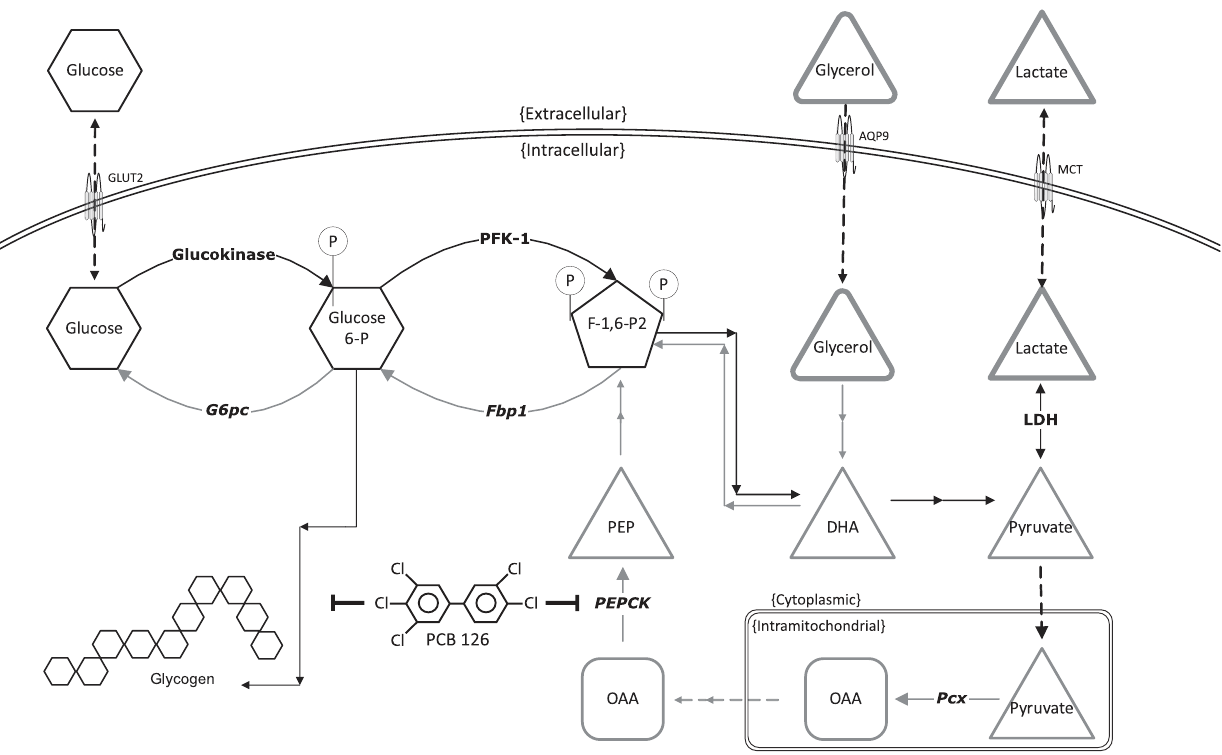
Figure 7. Simplified visual model of the impact of PCB 126 on hepatic glucose metabolism. Glycolysis, glycogen synthesis, and gluconeogenesis in a mouse hepatocyte are presented. Forward metabolism of glucose (glycolysis and glycogen synthesis) is depicted by black arrows, while reverse metabolism of glucose (GNG) is denoted by gray arrows. Enzymes involved in forward glucose metabolism are in standard bold text, while enzymes involved in reverse glucose metabolism are in italicized bold text. In this model, PCB 126 inhibits GNG from lactate (and pyruvate) by suppression of PEPCK gene transcription, and also inhibits glycogen by an unknown mechanism. GNG from glycerol is not affected by PCB 126 because glycerol is under the control of Fbp1 and G6pc under conditions that promote GNG, and thus bypasses